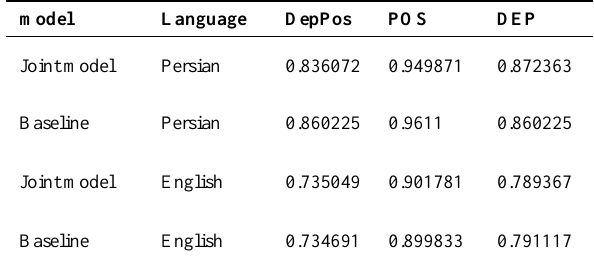
Table 5. Model first result for